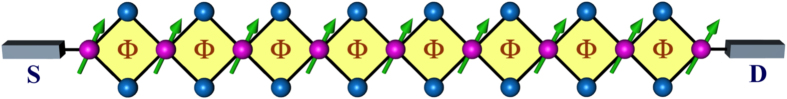
Graphical representation of a diamond array quantum network sandwiched in-between two leads.Schematic diagram of a diamond array network with magnetic-nonmagnetic distribution of atomic sites. The blue spheres represent the non-magnetic sites whereas, the magenta ones correspond to the magnetic sites described by a local magnetic moment (green arrow). The whole network is connected to two non-magnetic semi-infinite ordered leads, namely, source (S) and drain (D).